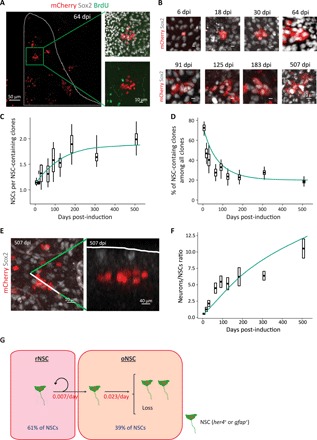
Hierarchical organization of pallial NSCs.(A) Dorsal view of a pallial hemisphere exemplifying some clones recovered at 64 dpi (magnification of the boxed area shows one clone). The analyzed region is outlined with dotted lines. (B) 3D reconstruction of clones at different time points illustrating the progressive increase in their NSC content until 183 dpi. (C) Time evolution of the number of NSCs (i.e., Sox2+ cells) per NSC-containing clone. (D) Time evolution of the proportion of NSC-containing clones among all clones. (E) Left: 3D reconstruction of a multicelled fully neuronal clone at 507 dpi. Right: Optical section along the plane defined by the dotted line on the 3D reconstruction (left). Note that the clone does not contain NSCs anymore and is completely detached from the ventricular zone (dotted line). (F) Time evolution of the ratio of neurons to NSCs within the entire population of traced cells. (G) Schematic illustrating the simplified model used for maximum likelihood estimation. The inferred activation frequency and relative proportions of both rNSCs and oNSCs are given in red and blue, respectively (rNSC ➔ rNSC + oNSC, ν = 0.007 day−1; oNSC ➔ oNSC + oNSC, λ = 0.006 day−1; oNSC ➔ loss, μ = 0.017 day−1). (C and D) Box-and-whisker plots, experimental data. The central bold bar and the upper and lower edges of the boxes represent the means and SEM of the most likely clonal composition, respectively; the whiskers of the box respectively correspond to the 95% CIs of the most extreme clonal assignments still in agreement with clonality (see Supplementary Materials). They reflect the combined uncertainty stemming from the clonal reconstruction and the finite sample size. (C, D, and F) Clones as defined by the algorithm. n = 6, 3, 3, 3, 4, 6, 7, 9, and 7 brains at 6, 18, 30, 64, 91, 125, 183, 307, and 507 dpi, respectively. Solid lines depict modeling predictions.